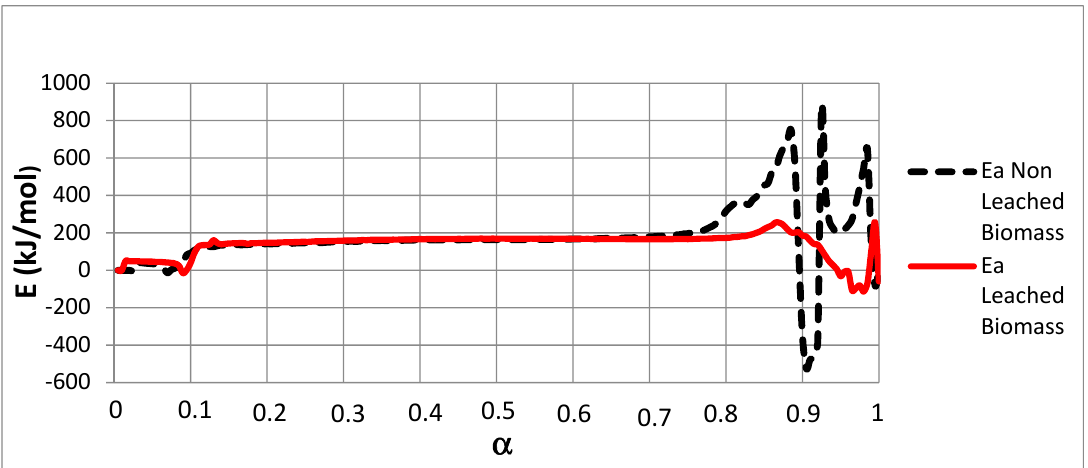
Figure 4. d α /dt versus α for ( a ) NL-B and ( b ) L-B samples at 50 °C/min heating ramp.